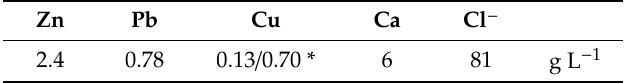
Table 1. Concentration of elements Zn, Pb, Cu, Ca, and Cl − in municipal solid waste incineration (MSWI) fly ash extract used for retention experiments. * Achieved by addition of CuNO 3